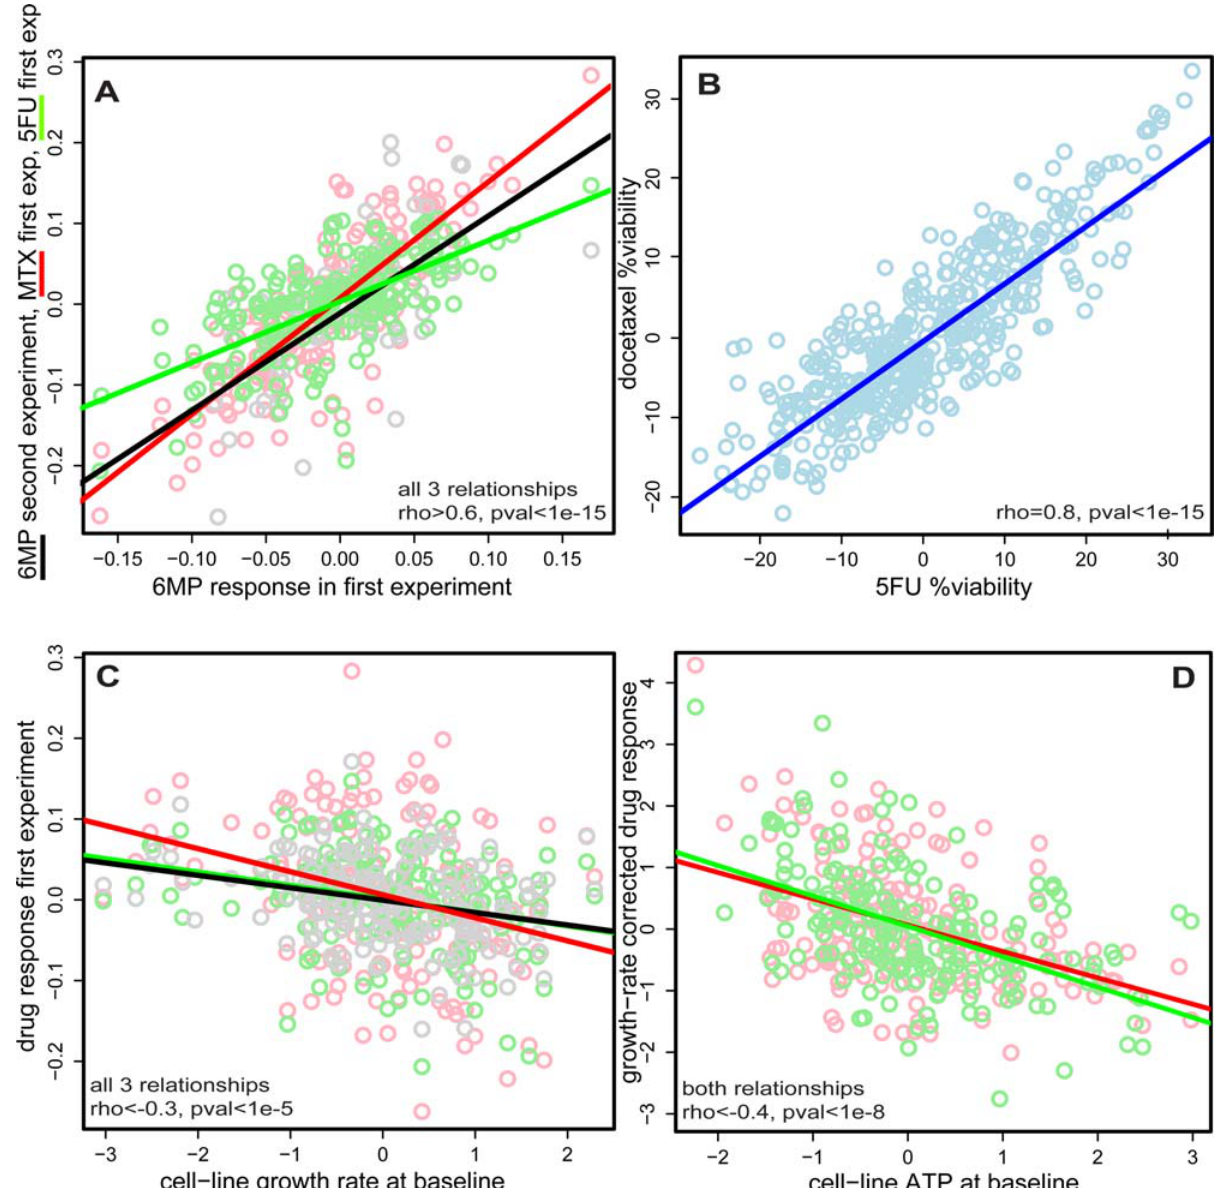
Figure 2. Drug response is correlated across multiple drugs, to growth rate and to baseline ATP levels of the cell line. (A) Relative drug responses were calculated for each individual as described in Methods to obtain a single number summary of the cell line response to each drug on each day. The black circles represent an individual cell line’s relative response to 6MP assayed on day one plotted against 6MP relative response assayed on day two. The red circles similarly represent relative response to 6MP plotted against relative response to MTX, both assayed on day one. The green circles represent relative response to 6MP plotted against relative response to 5FU, again both assayed on day one. Lines represent regressions for each of the three comparisons and show that not only is relative drug response a reproducible trait, but also can be correlated across multiple drugs. (B) Using online data made publicly available by Watters et al. [25], relative drug response to docetaxel and 5FU was calculated using the 427 individuals with no missing data to obtain a single number for each drug, in each individual, as in (A). Response to docetaxel was plotted against 5FU for each individual. The line represents the regression for the comparison and indicates that the effect observed in (A) is neither limited to our experiments, nor to the particular drugs we attempted. (C) The baseline growth-rate of each individual’s cell line was estimated as described in the Methods. This growth rate is plotted against relative response for 6MP (black), MTX (red), and 5FU (green). Lines represent regressions for the respective comparisons and all correspond to significant correlations. (D) For each individual, baseline ATP levels were measured using Celltiter glo in the mock-treated wells in drug response assays. EC50 response was calculated correcting for growth rate (see Methods). Relative ATP levels were plotted against the growth-rate corrected EC50 for MTX (red), and 5FU (green). Lines represent regression for the comparisons and indicate significant correlations. doi:10.1371/journal.pgen.1000287.g002 rate in LCLs, though not previously reported, is unsurprising: all exponential growth under exposure to drug (see Methods), we three agents depend upon cell division. Using a differential estimated a growth rate adjusted EC50 for each cell line for each equation model of drug response accounting for the kinetics of of the three affected drugs. This approach removed the bulk of the